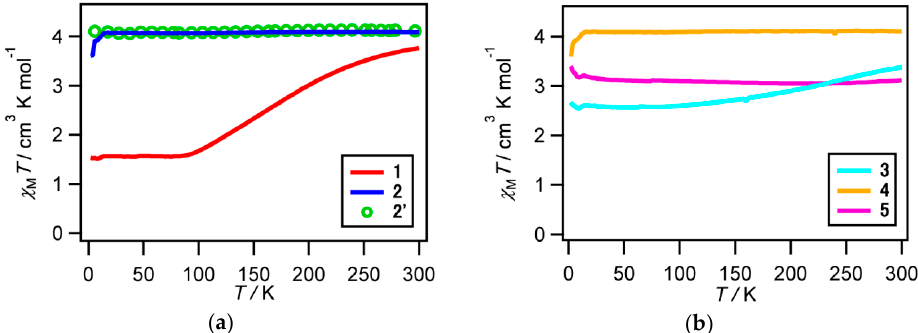
Figure 3. χ M T vs. T products of the [Fe(aznp) 2 ] compounds. ( a ) acetonitrile-solvate compound 1 (red), acetone-solvate compound 2 (blue), and acetone-desolvate compound 2’ (green circle); ( b ) compounds 3 (cyan), 4 (orange), and 5 (magenta). The scan rate was 2 K·min − 1 .